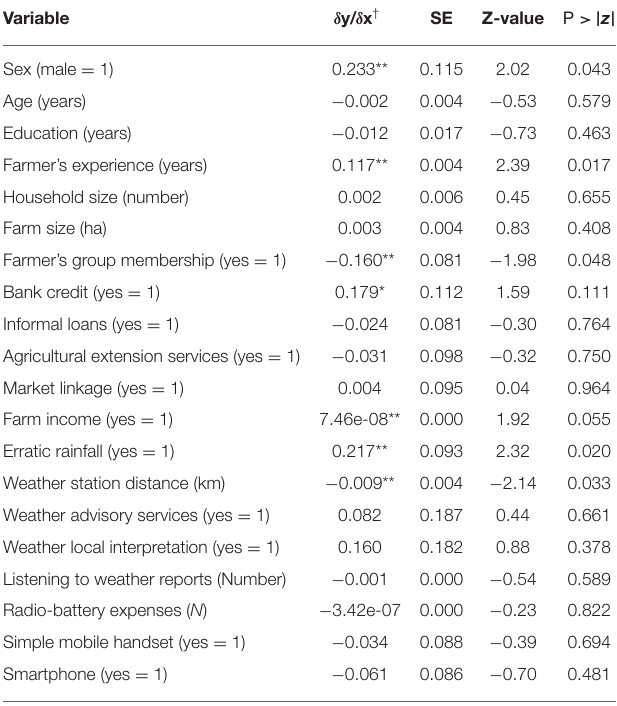
TABLE 6 | Marginal impact of using WCI in drought hazard